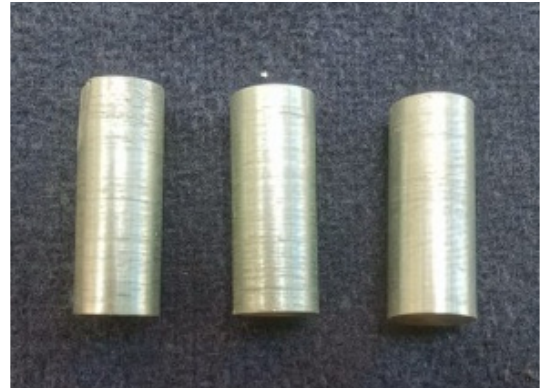
Figure 3. Compressive test specimens.